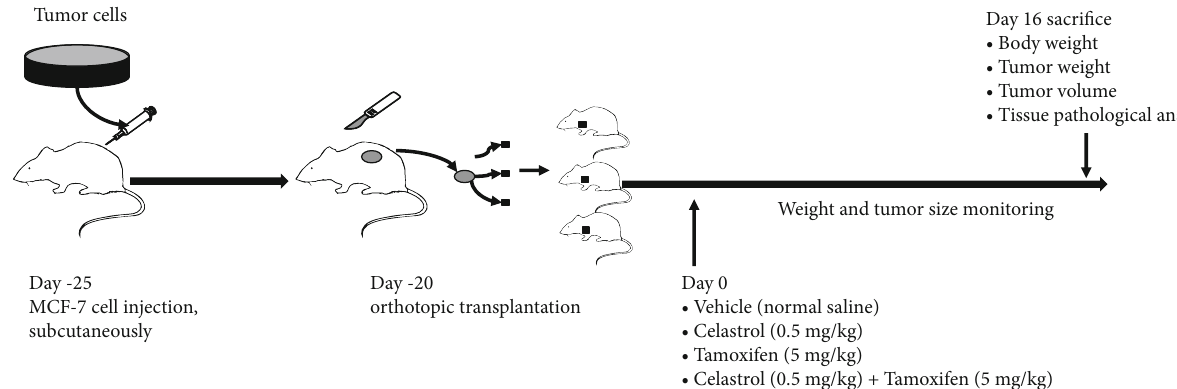
Figure 6: In vivo study